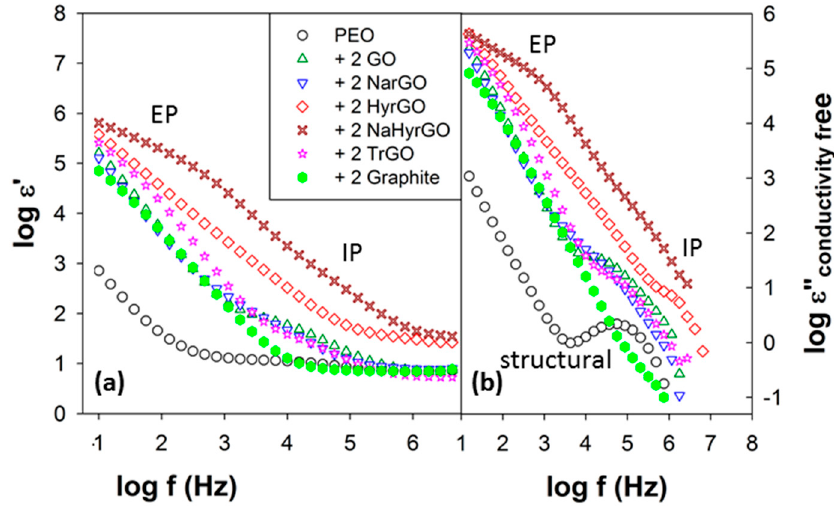
Figure 9. ( a ) Real part of dielectric permittivity and ( b ) Conductivity-free dielectric loss spectra calculated from ( a ) of PEO and PEO nanocomposites containing 2 wt % of various fillers at 100 °C. The electrode polarization (EP) at low frequencies, interfacial polarization (IP) in nanocomposites and structural relaxations in PEO at high frequencies have been demarcated in the permittivity responses.